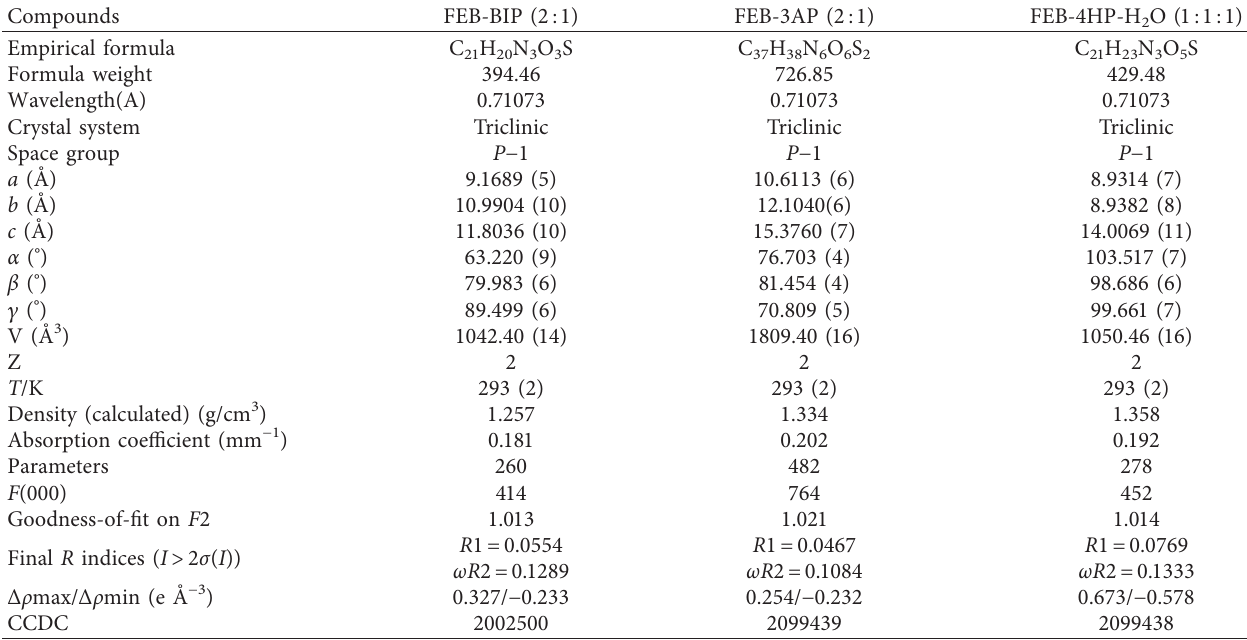
Table 1: Crystallographic parameters of FEB cocrystal and salts.